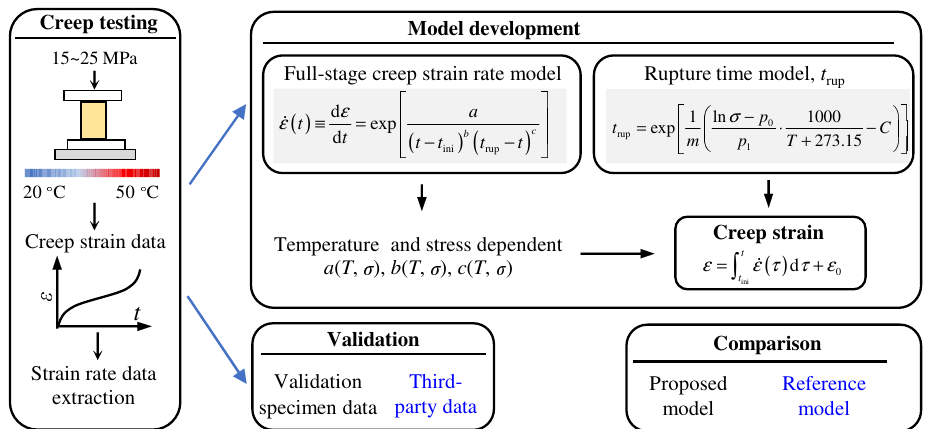
Figure 2. Overall diagram of creep testing, model development, validation, and comparison.